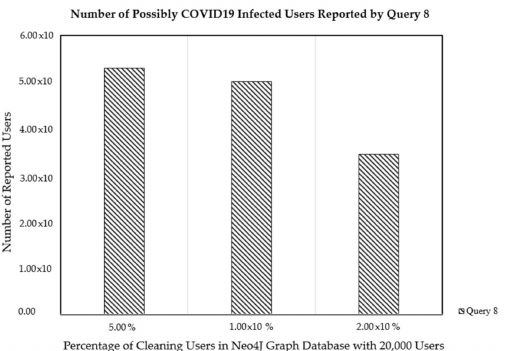
Figure 16. Number of possible COVID-19 infected users reported by Query 8 in the Neo4j database with 20,000 users and different percentages: 5 percent, 10 percent, and 20 percent of cleaning